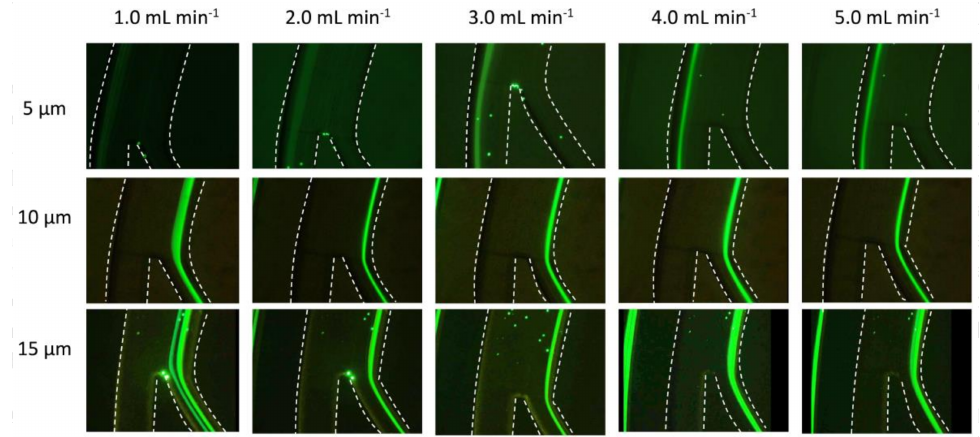
Figure 5. Microparticles focusing paths vs. flow rate of fluid in the proposed trapezoidal spiral channel (dashed lines used to highlight microchannel